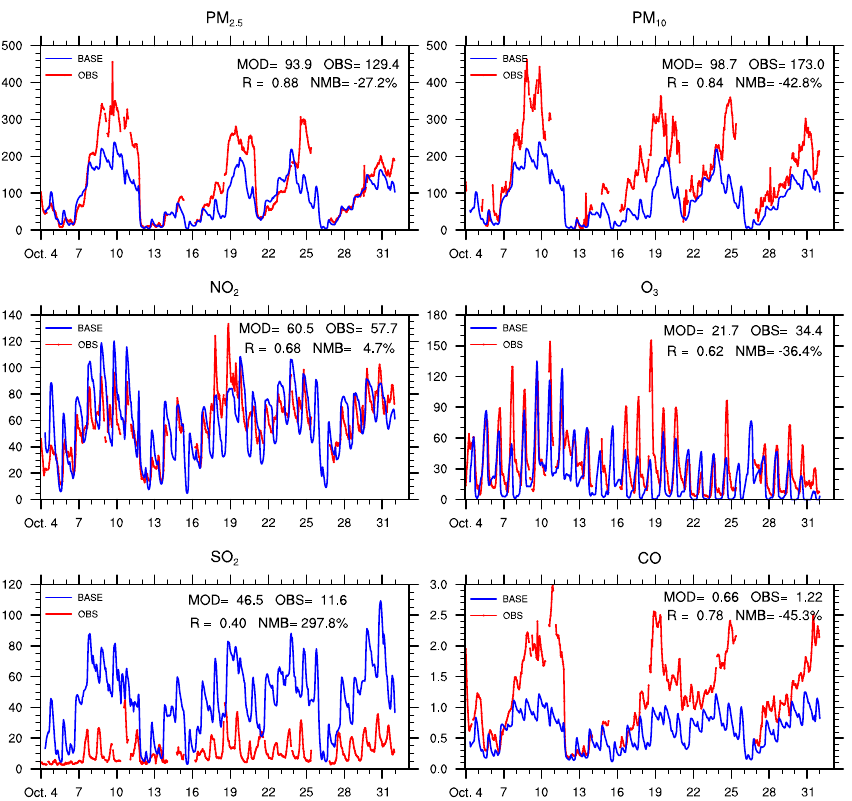
Figure 5. Time series of observed averaged pollutant concentrations at 34 sites in Beijing (from local monitoring system) along with the results from the BASE simulation. Units are mgm − 3 for CO and µgm − 3 for the other